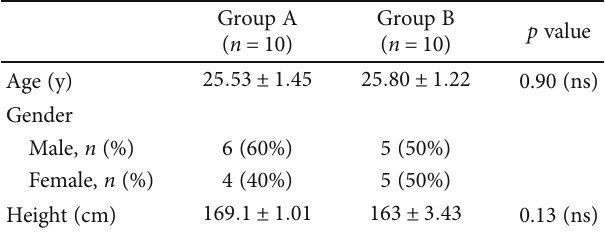
Table 1: Comparison of demographic characteristics between both groups in the study. Abbreviations: y=years; cm=centimeters; ns=not signi fi